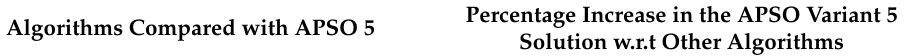
Table 4. Comparison of the APSO 5 solution with other algorithm’s solutions in terms of percentage increase for the 50-PHEV dataset.